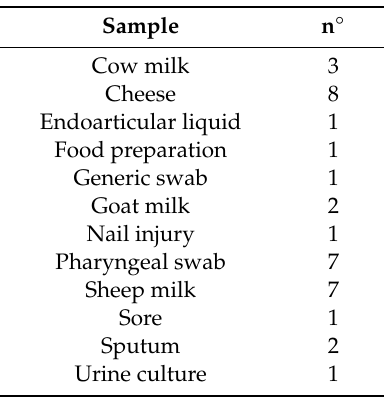
Table 5. The 35 S. aureus samples collected from di ff erent specimens between December 2017 and February